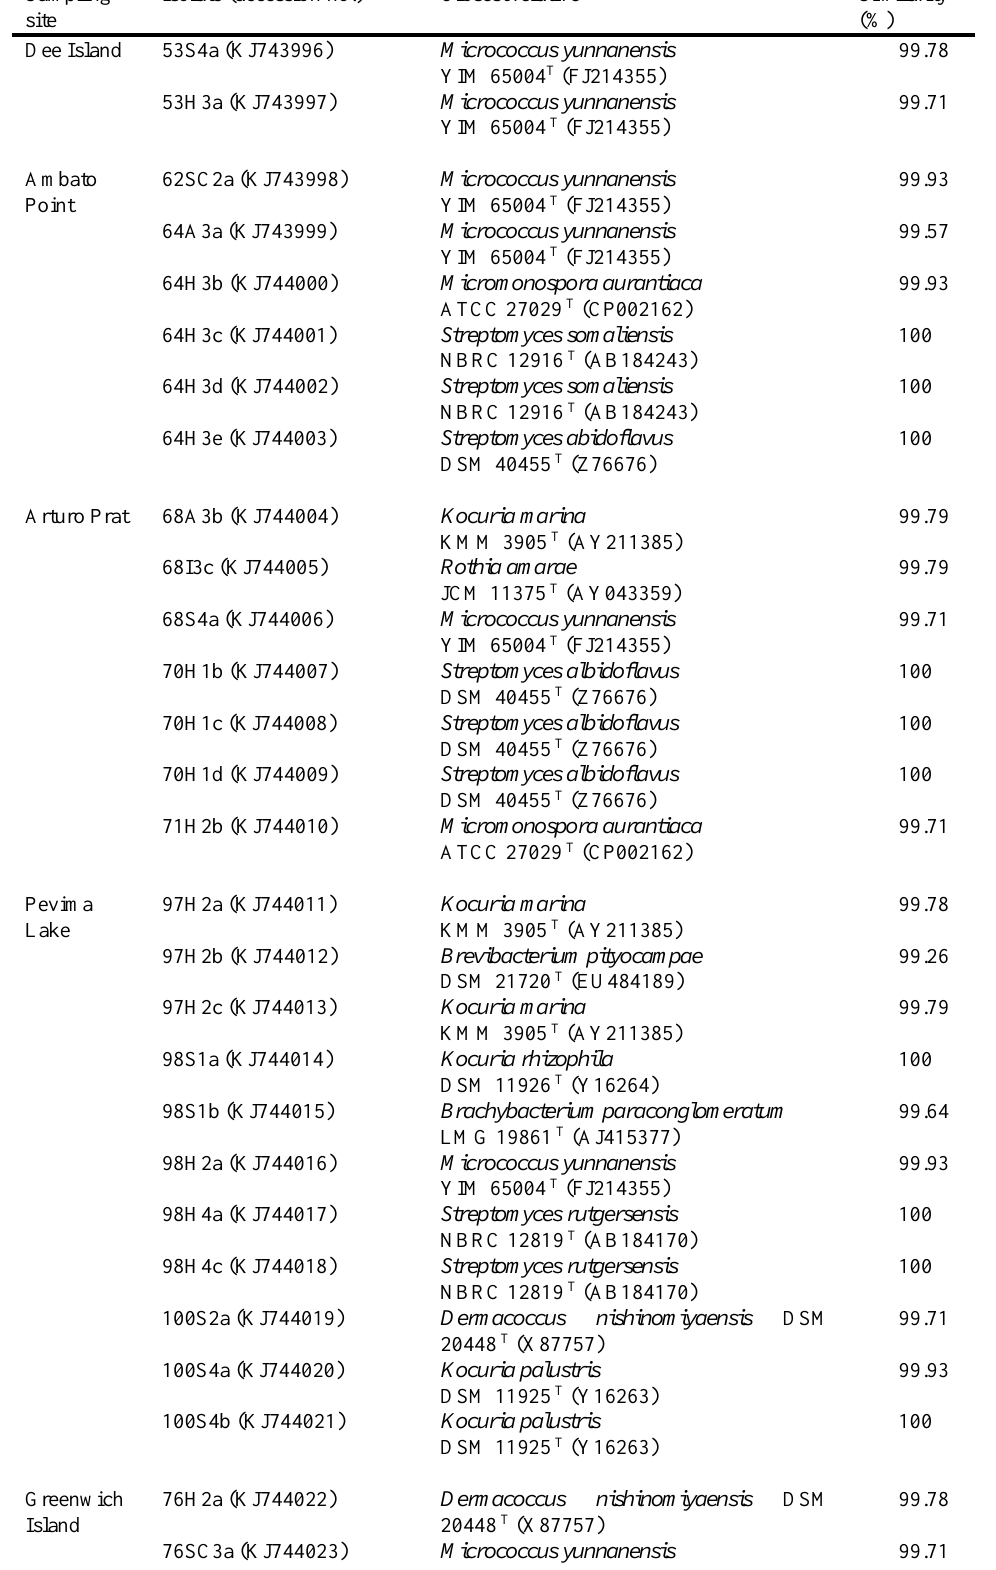
Table 2 List of Actinobacteria isolates in this